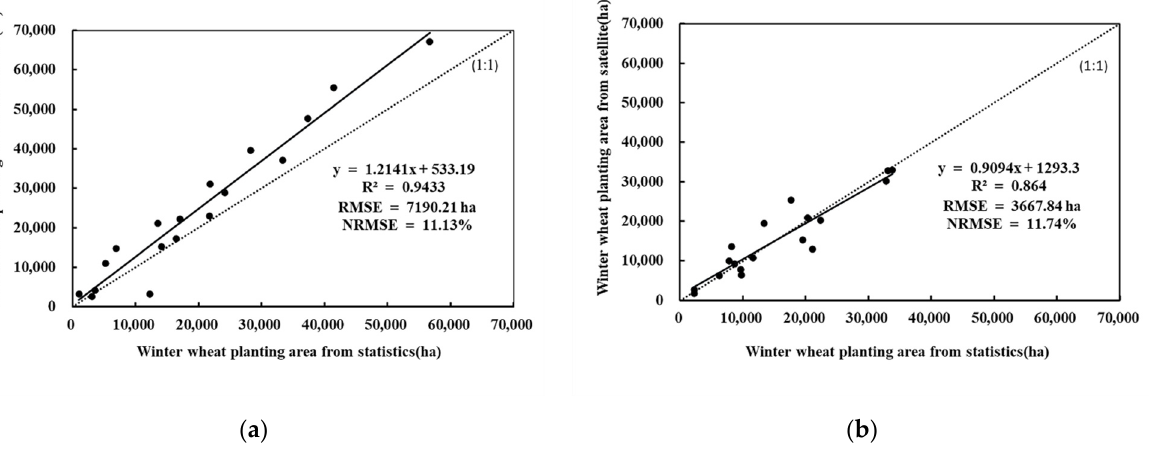
Figure 10. ( a ) The results of the extraction and statistical data of winter wheat in Handan. ( b ) The results of the extraction and statistical data of winter wheat in Baoding.